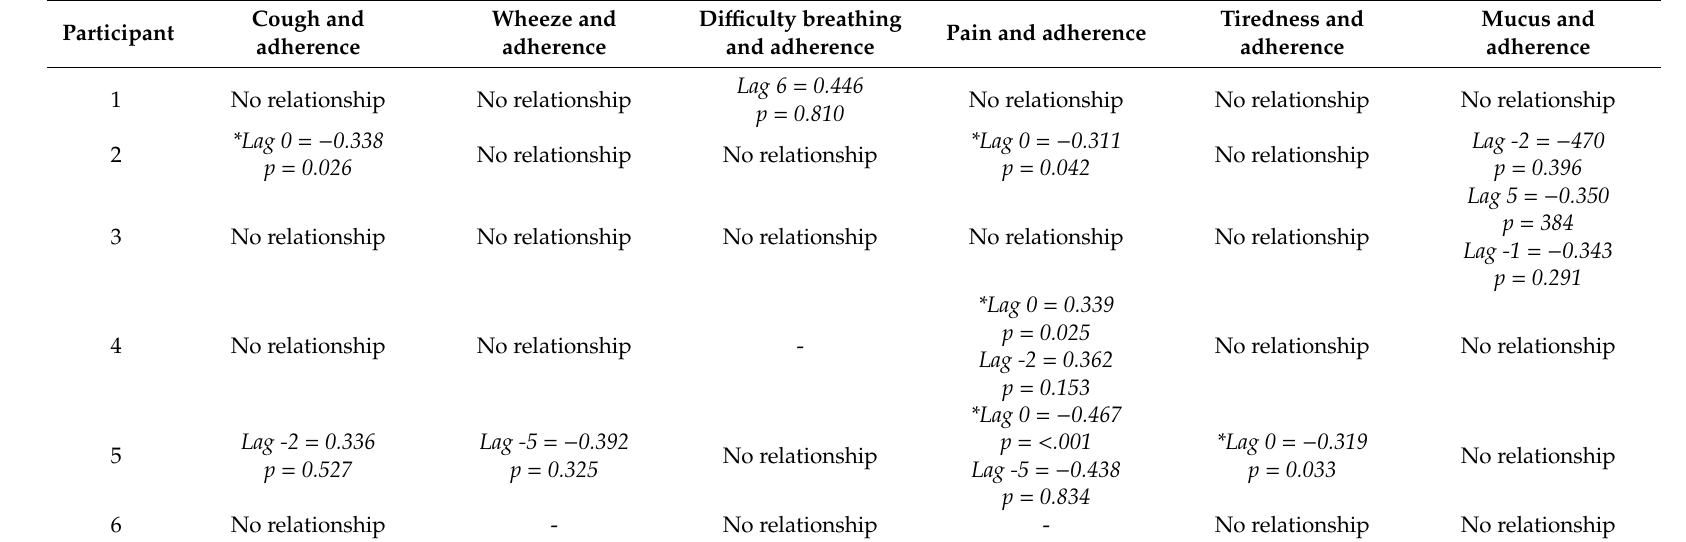
Table 5. Relationship between symptoms and adherence for all participants (regression